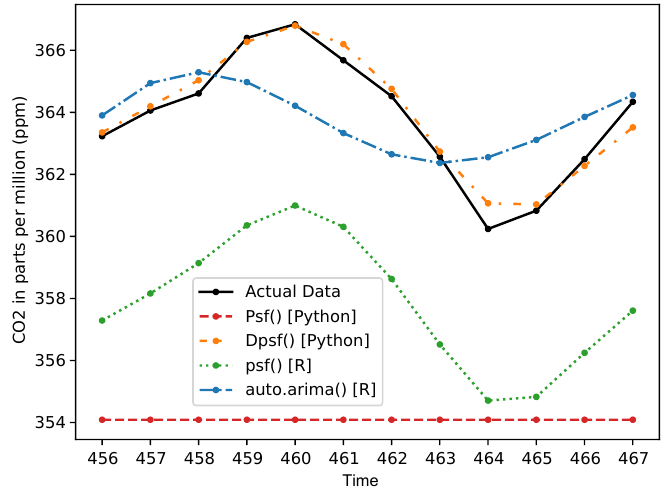
Figure 6. Plot showing the test data and values forecasted using various methods for the “CO 2 ” dataset.